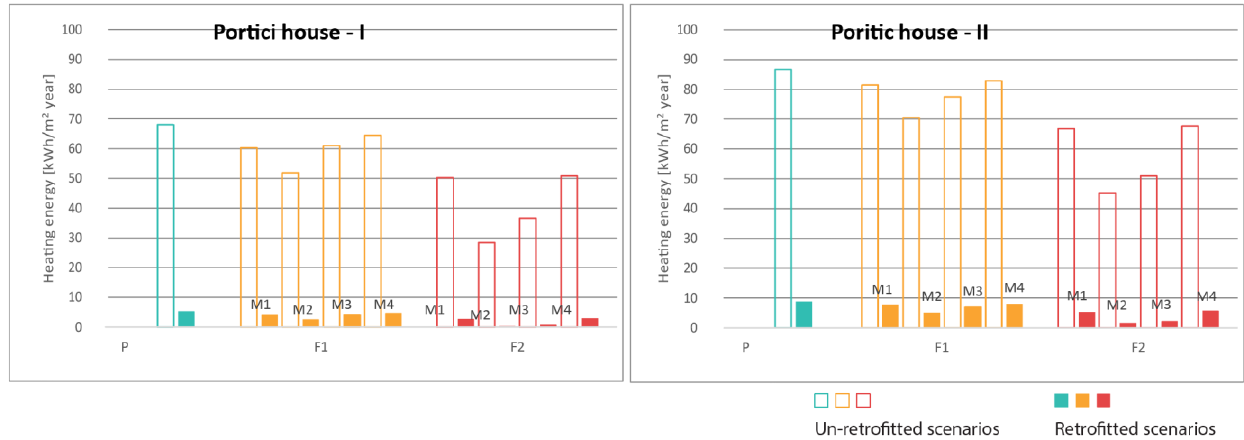
Figure 9. Average annual heating energy consumption of the whole building in kWh for retrofit- ted/un-retrofitted and present/future